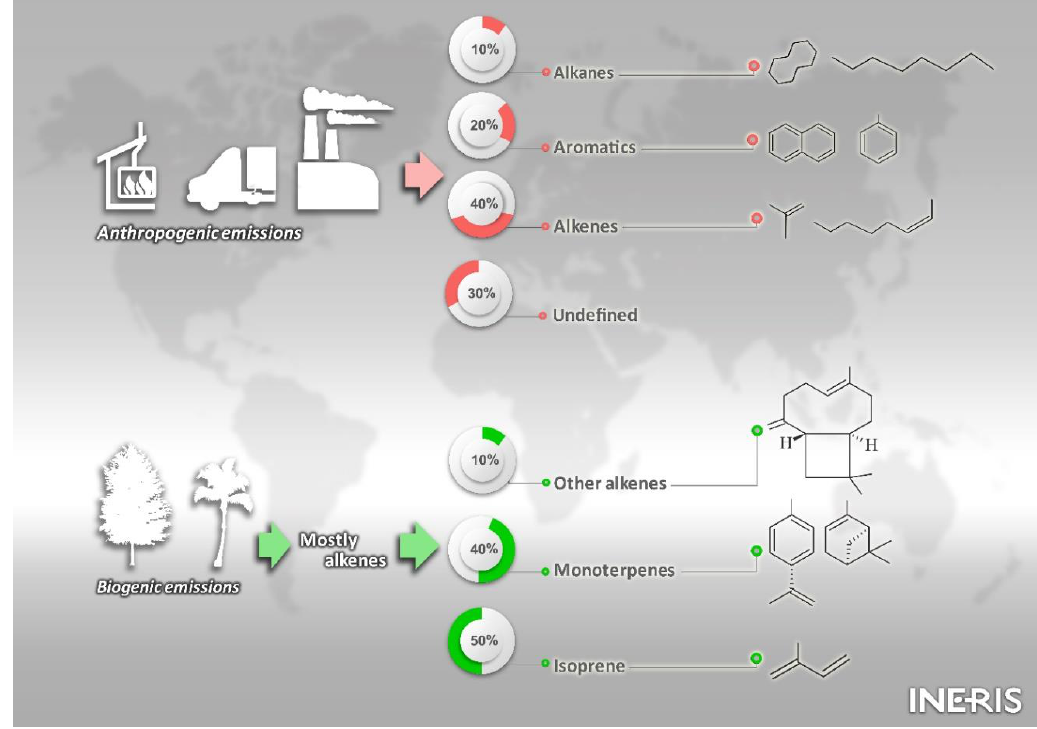
Figure 1. Distribution of the major classes of secondary organic aerosol (SOA) precursors (adapted from Ziemann and Atkinson, [11] ).